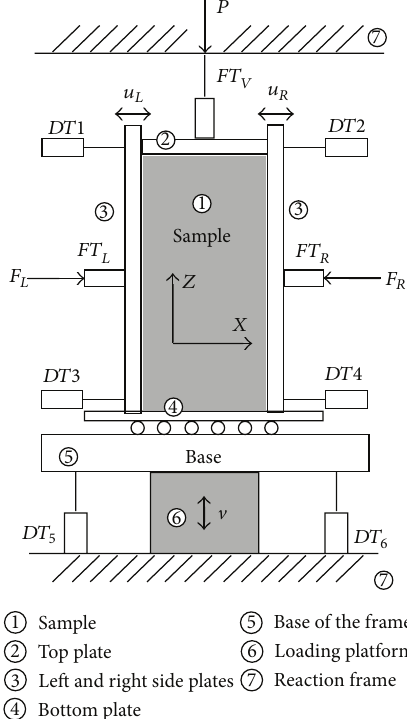
Figure 1: The structure diagram of the biaxial compression test equipment (Zhang